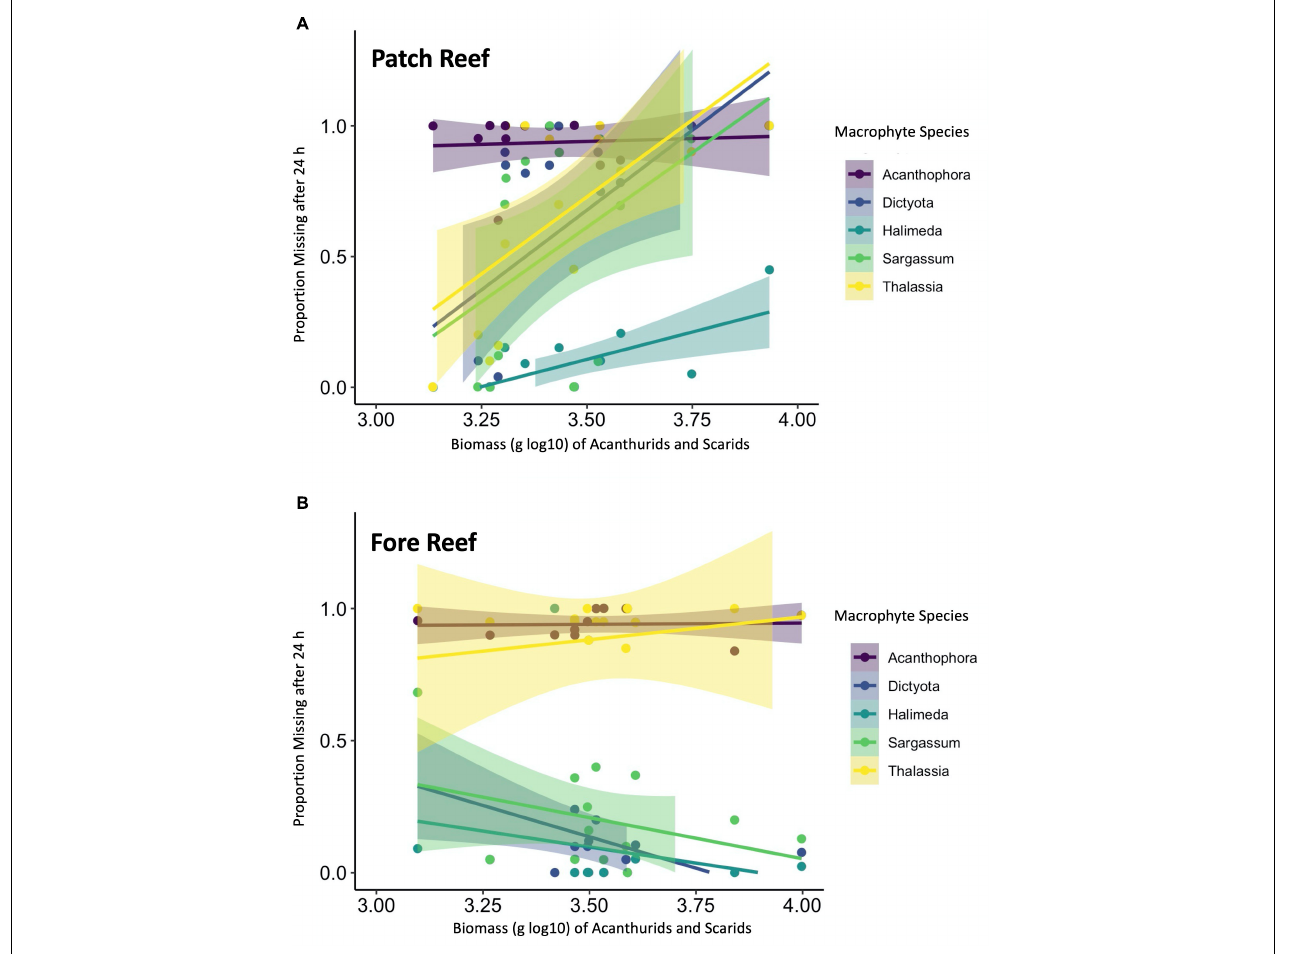
FIGURE 8 | Relationships between acanthurid and scarid fish biomass (log10 g) and macrophyte loss after 24 h in (A) fore reef and (B) patch reef habitats. Macrophyte types are color coded and confidence intervals were applied using a linear model